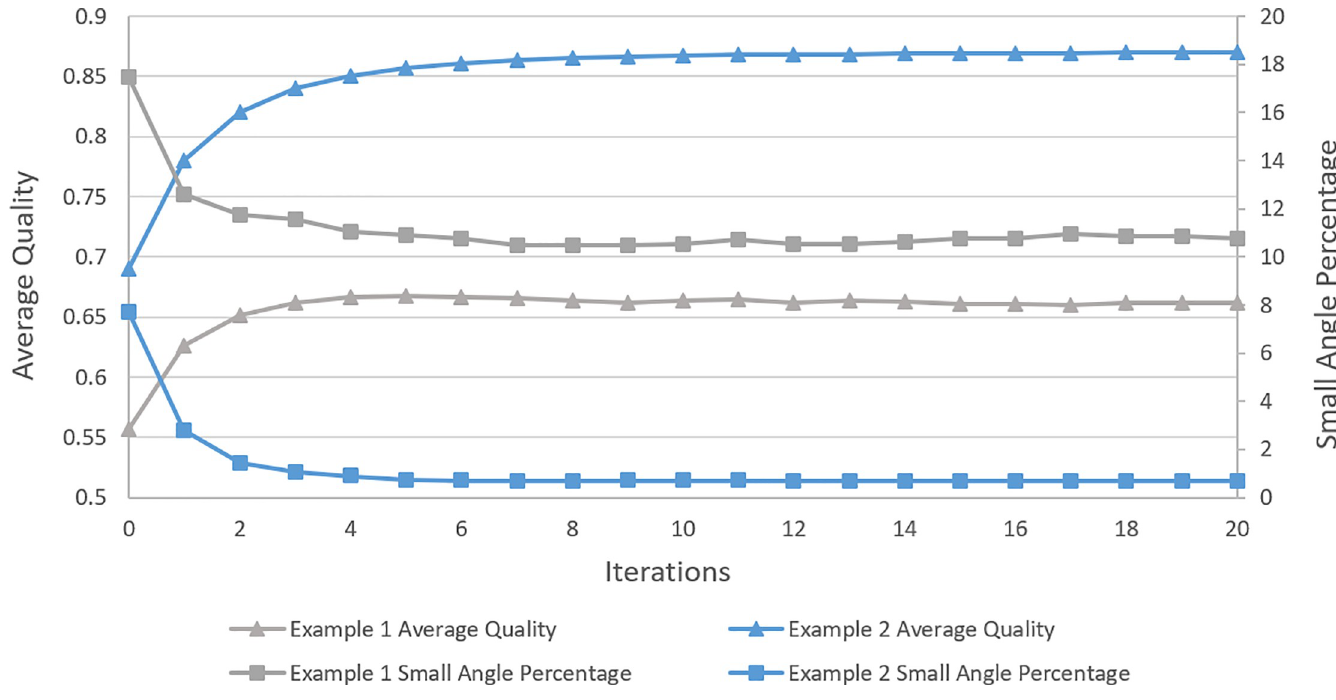
Fig 10. Convergence of EAS algorithm for quadrilateral mesh.